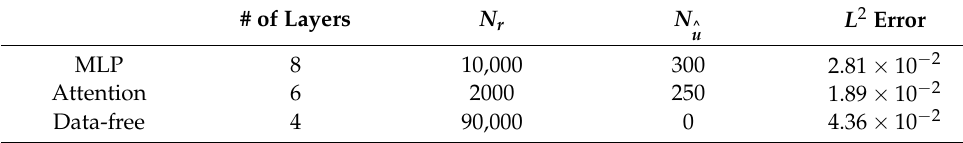
Figure 5. Comparison between PINNs solutions, MLP and attention-based, (dashed line) and the analytical solution (solid line) at six different times. Table 1. Comparison between the MLP and the attention-based